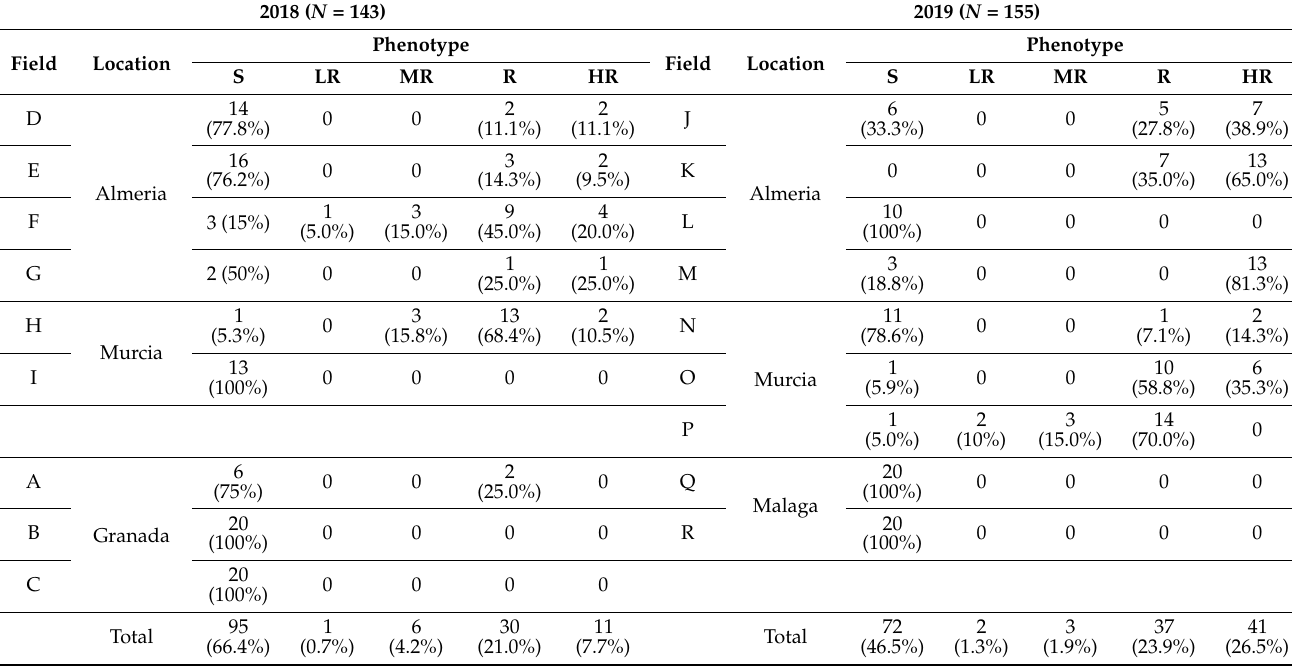
Table 4. Number and frequencies of fluopyram-sensitive and -resistant P. xanthii isolates collected from four different cucurbit production areas in Spain during 2018 and 2019 growing